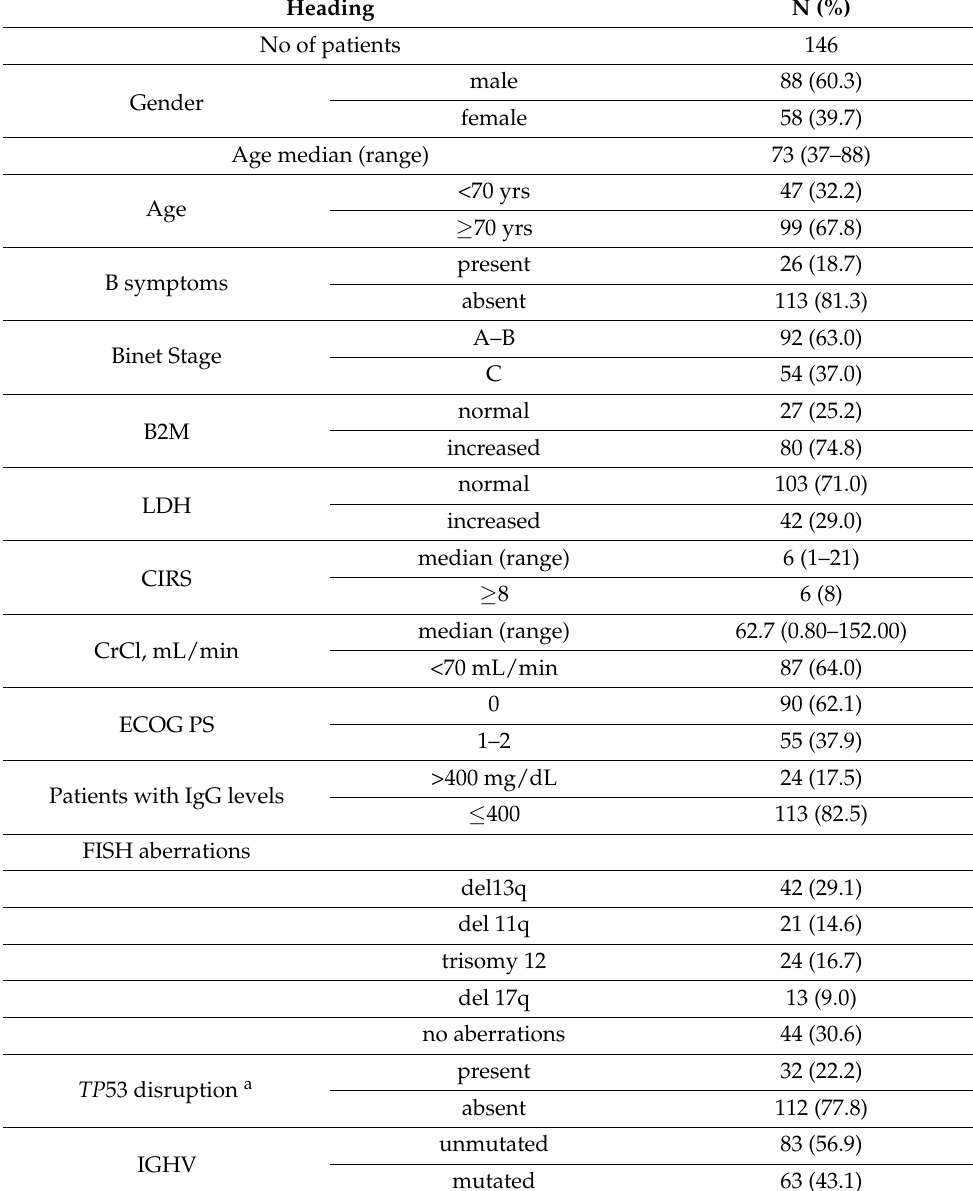
Table 1. Baseline clinical and biologic characteristics of